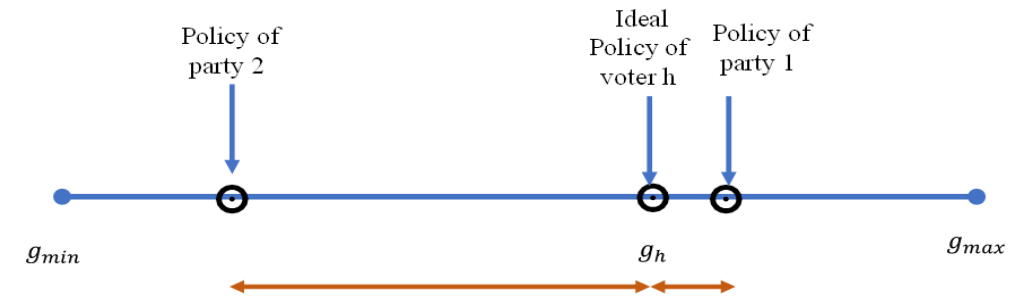
Figure 2. Policy positions of parties and the choice of the vote.